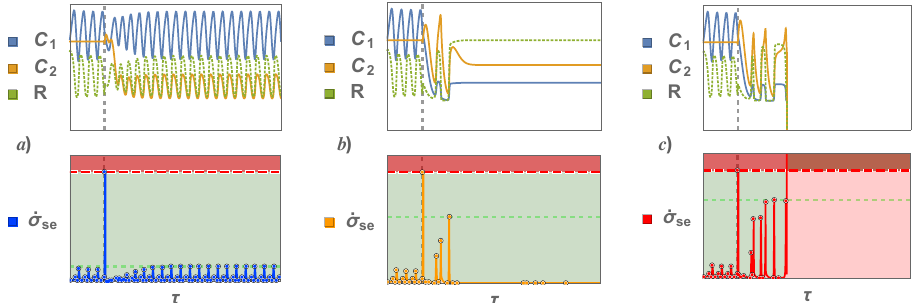
Figure 3. Illustration of the different nature of possible solutions in terms of the population dy- namics (upper panels) and the corresponding social-ecological entropy production (lower panels). ( a ) Sustainable: The post-intervention behavior of the entropy production reaches a new periodic behavior with an entropy production inferior to the threshold value, indicated by the horizontal red- dashed line. ( b ) Exhaust: The population reaches a time-independent value that makes the entropy production null. ( c ) Catastrophic: The post-intervention behavior leads to an entropy production behavior with larger values than the entropic threshold. The populations take shallow values that are non-compatible, with minimal survival populations. The figure is the authors’ own